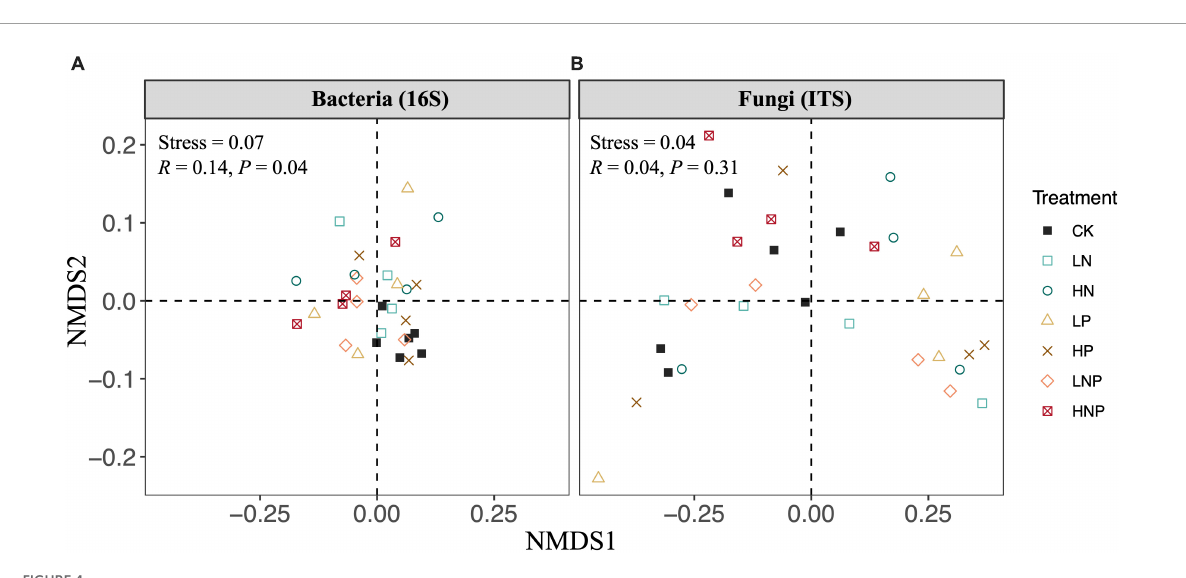
these three gene copies irrespective of application level ( Figure 6